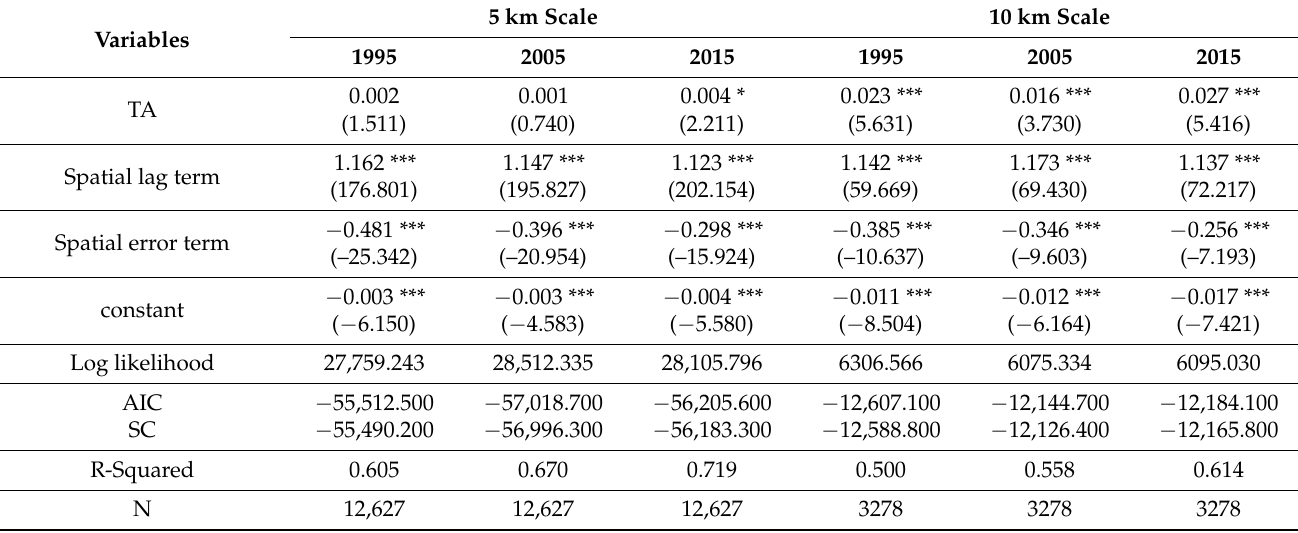
Table 2. Regression results of the spatial error models with lag dependence: 1995, 2005, and 2015.